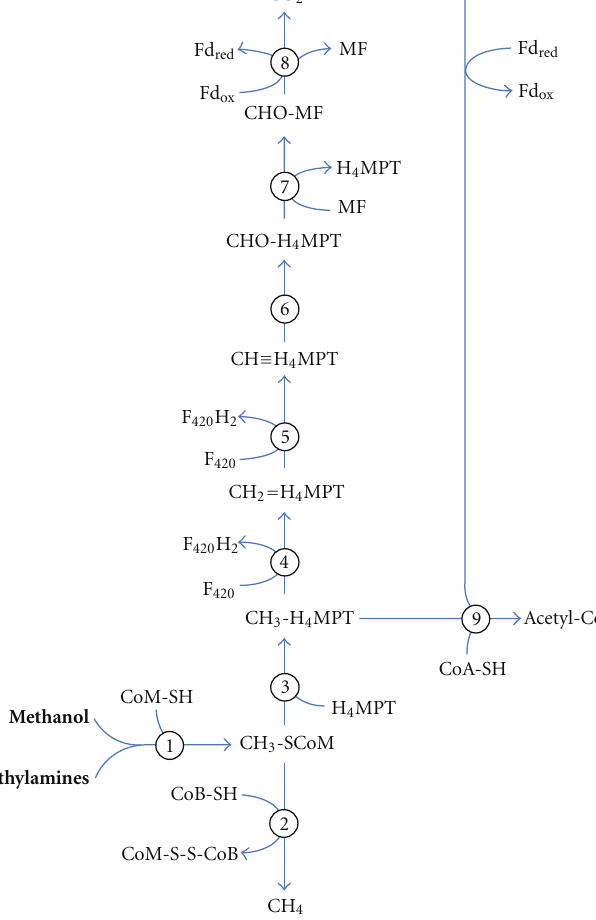
Figure 5: Proposed pathway of methanogenesis in Mhp. mahii . Numbers in circles indicate involved enzymes: (1), methyltransferase system; (2), methyl-CoM reductase; (3), methyl-H 4 MPT:HS-CoM methyltransferase; (4), methylene-H 4 MPT reductase; (5), methylene-H 4 MPT dehydrogenase; (6), methenyl-H 4 MPT cyclohydrolase; (7), formyl-MF:H 4 MPT formyltransferase; (8), formyl-MF dehydrogenase; (9), acetyl-CoA synthase/CO dehydrogenase. Abbreviations: Fd red , reduced ferredoxin; Fd ox , oxidized ferredoxin; MF, methanofuran; H 4 MPT, tetrahydromethanopterin; F 420 H 2 , reduced coenzyme F 420 ; F 420 , oxidized coenzyme F 420 ; CoA-SH, coenzyme A; CoM-SH, coenzyme M; CoB-SH, coenzyme B; CoM-S-S-CoB, heterodisulfide of CoM and